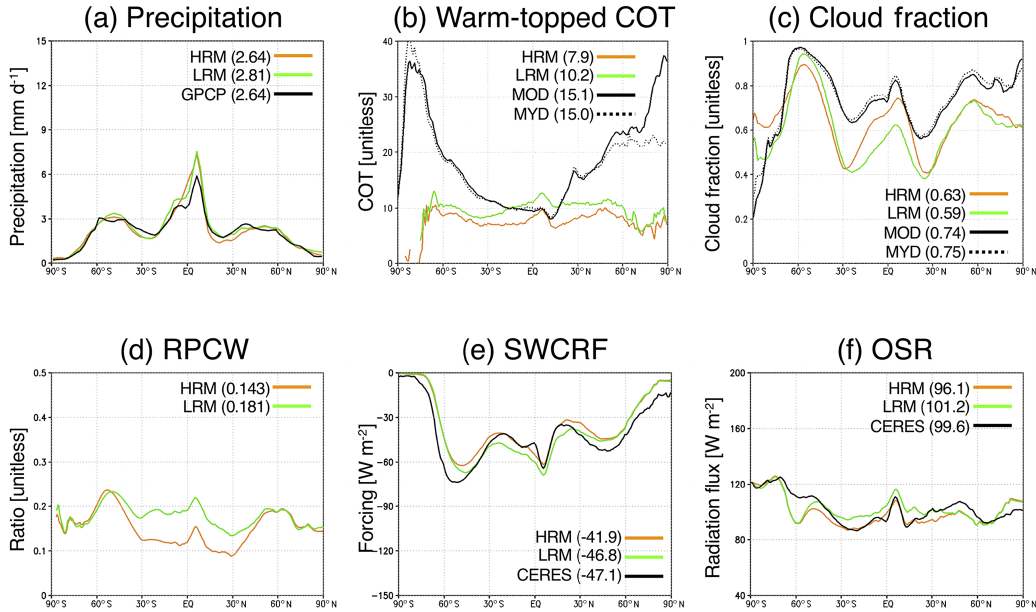
Figure 3. Zonal distributions of the annual averages of (a) precipitation, (b) cloud optical thickness (COT) for warm-topped clouds, (c) cloud fraction (CF) in all types of clouds, (d) ratio of precipitation to total cloud water (RPCW) at a height of 2km, (e) shortwave cloud radiative forcing (SWCRF) and (f) outgoing shortwave radiation flux (OSR) simulated by the HRM and LRM, reanalyzed by the GPCP only in panel (a) , retrieved from both MODIS/Terra (MOD) and MODIS/Aqua (MYD) in panels (b) and (c) , and estimated by CERES in panels (e) and (f) . The annual averages of these variables except for CF and COT are calculated by a 3-year integration, whereas those in CF and COT are calculated by a 1-year integration using 6-hourly instantaneous clouds at 12:00LT (local time) to more exactly compare them with the MODIS/Terra observation at approximately 10:30LT and with the MODIS/Aqua observation at approximately 13:30LT. The numbers shown in the captions represent the global and annual averages for NICAM (HRM or LRM) and the reference data. The units are described in each